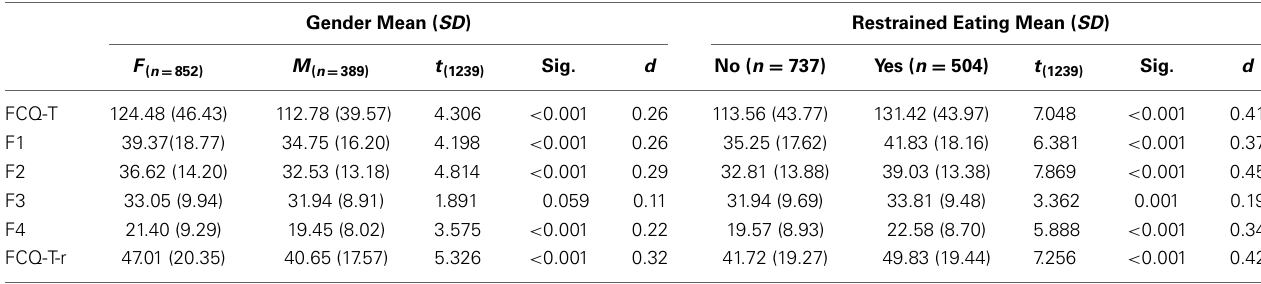
Table 4 | Food cravings comparisons acording to gender and restrained eating.